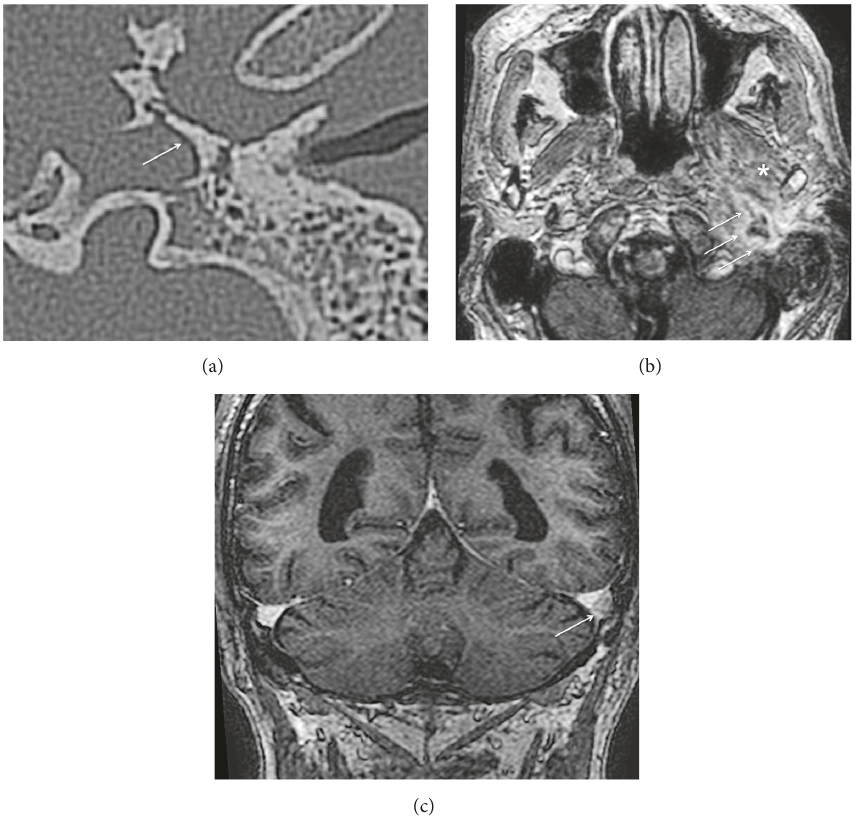
Figure 2: (a) CT scan of the left temporal bone—a bony sequestrum in the tympanic part is shown by the arrow. (b) An abscess in the left infratemporal fossa appears as a contrast-enhanced mass on the periphery, with irregular contours (arrows). A trismus was explained by inflammatory infiltration of the lateral pterygoid muscles (asterisk). (c) A thrombosed sigmoid sinus is seen on the left side